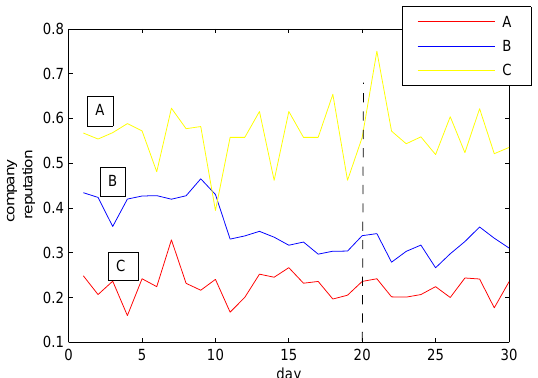
Fig. 4. Companies’s Vague Reputation Comparison